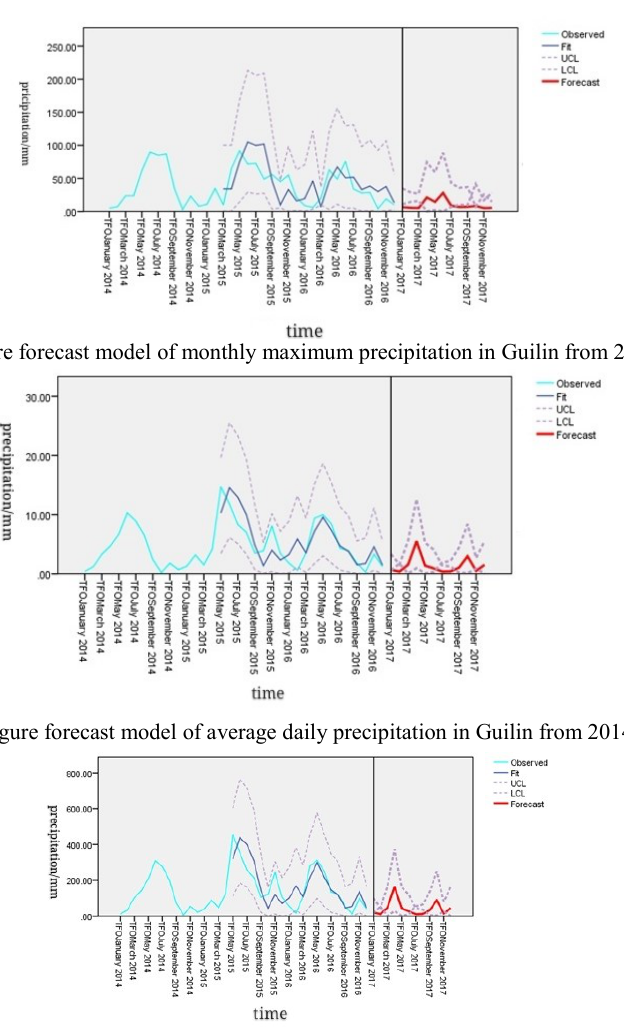
Figure 3 Figure forecast model of total precipitation per day per monthly in Guilin from 2014 to 2017